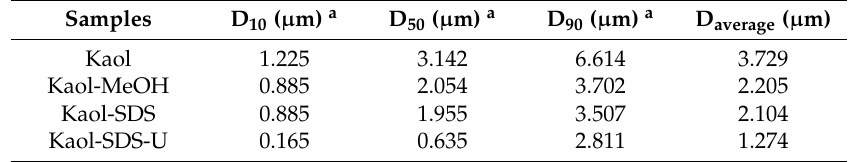
Figure 5. Particle size distribution curves of ( a ) Kaol, ( b ) Kaol-MeOH, ( c ) Kaol-SDS and ( d ) Kaol-SDS-U. Table 3. The particle size of raw Kaol and Kaol with different exfoliation methods.